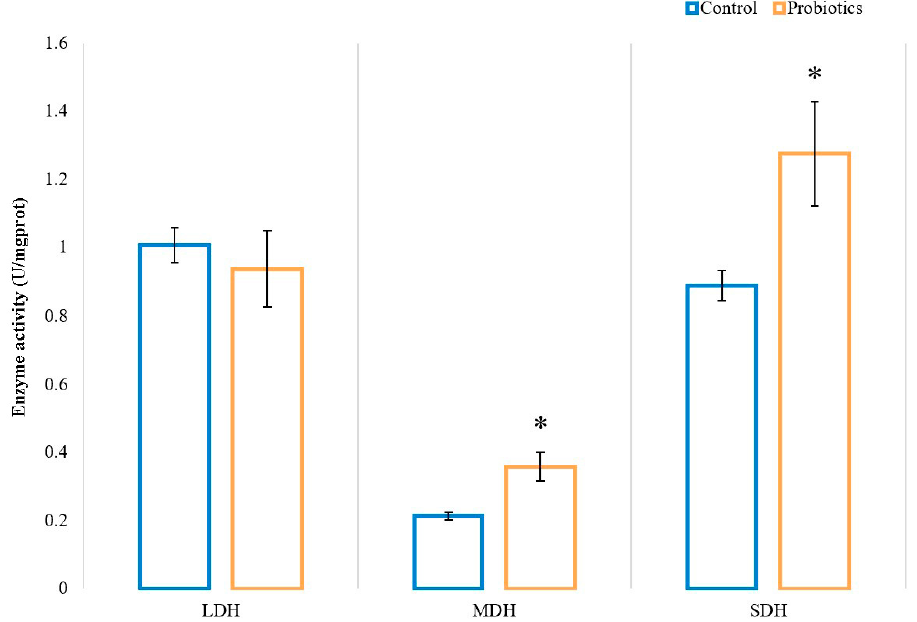
Figure 4. Effect of probiotics on the LDH, MDH, and SDH activities of the muscle longissimus thoracis. * indicates a statistically significant difference ( p < 0.05).